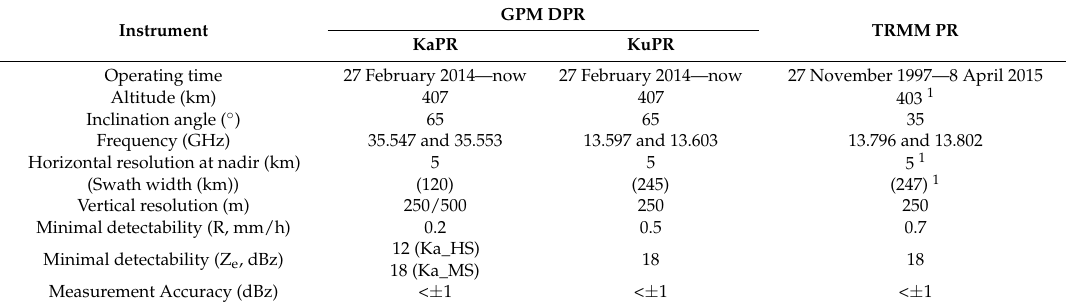
Table 1. Brief description of GPM DPR and TRMM